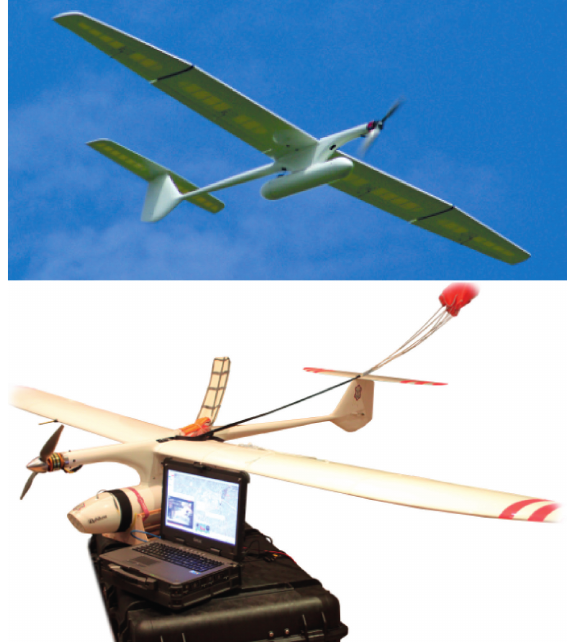
Fig. 6. The unmanned aircraft developed in the